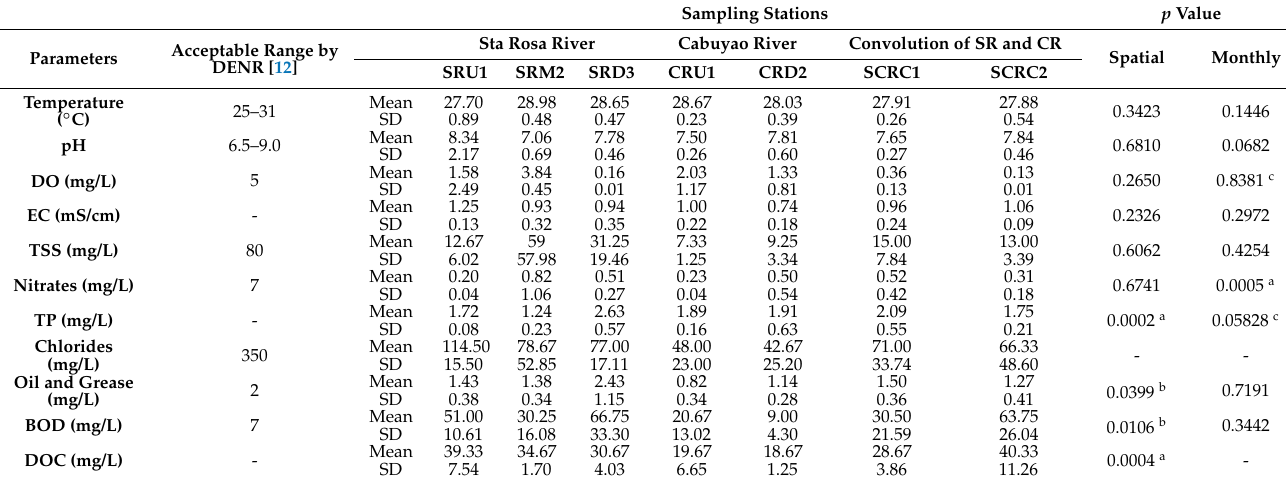
Table 6. Water quality parameters measured in SR and